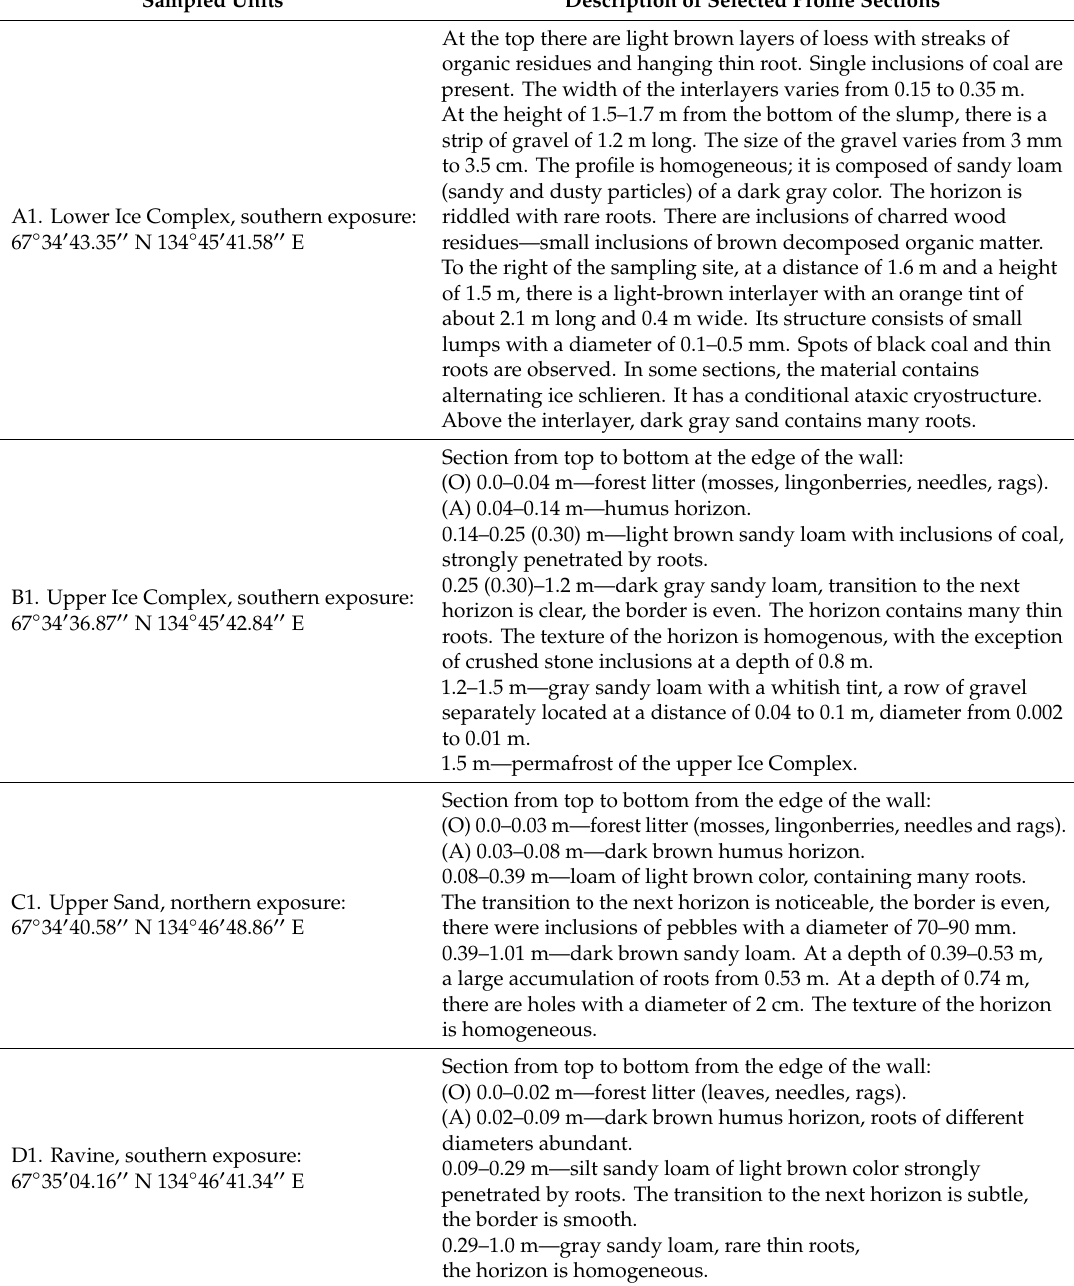
Table 1. Cryolithological characterization of the studied stratigraphic features exposed in the Batagay